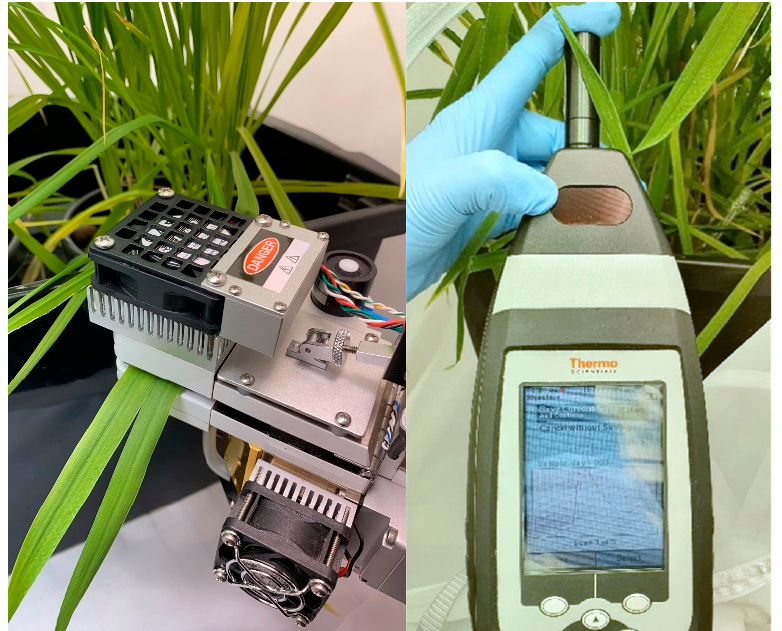
Figure 2. Photosynthetic gas exchange ( left ) and near-infrared ( right ) devices while taking measurements.